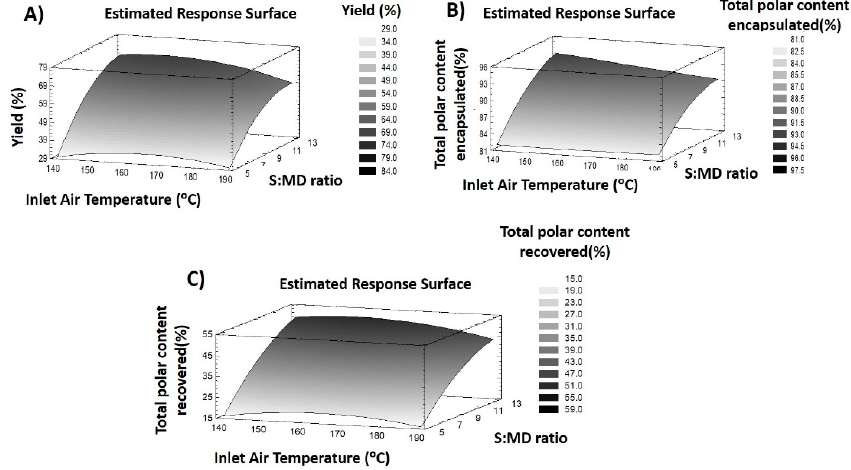
Figure 1. Response surface methodology (RSM) plots of responses of maltodextrin (MD) particles: ( A ) Yield, ( B ) Total polar encapsulation and ( C ) Total polar recovery. Sample:Maltodextrin (S:MD)